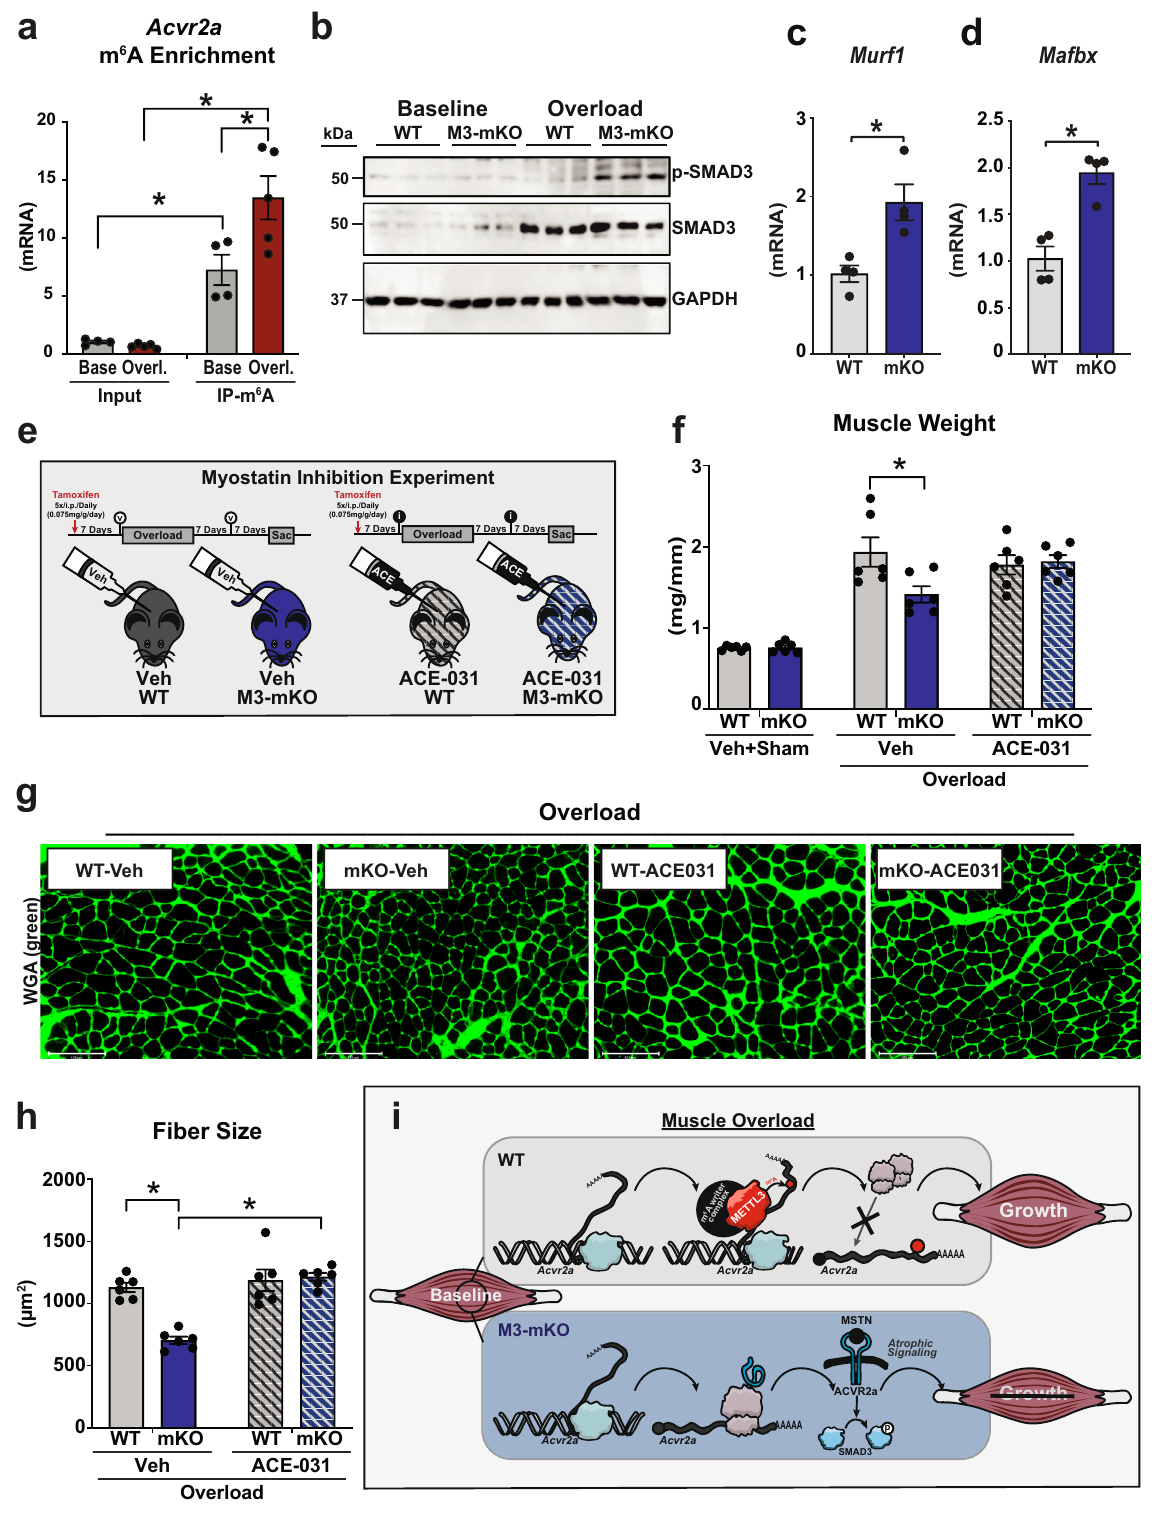
ablation overloaded plantaris muscles and subjected to m 6 A quanti fi cation using the m 6 A RNA Methylation Quanti fi cation Kit (Colorimetric) (#ab185912, Abcam) in biological triplicate as previously described 42 . For genome-wide m 6 A pro fi ling, total RNA was isolated from muscle plantaris of baseline and overloaded WT mice using Qiagen RNeasy Fibrous Tissue Mini Kit (# 74704, Qiagen) per manufacturer ’ s instructions. Total RNA samples were pooled to a total RNA amount of ~20mcg/ sample and processed using Invitrogen PolyA + RNA selection (Dynabeads mRNA Puri fi cation Kit (Cat # 61006) according to the manufacturer ’ s protocol. RNA